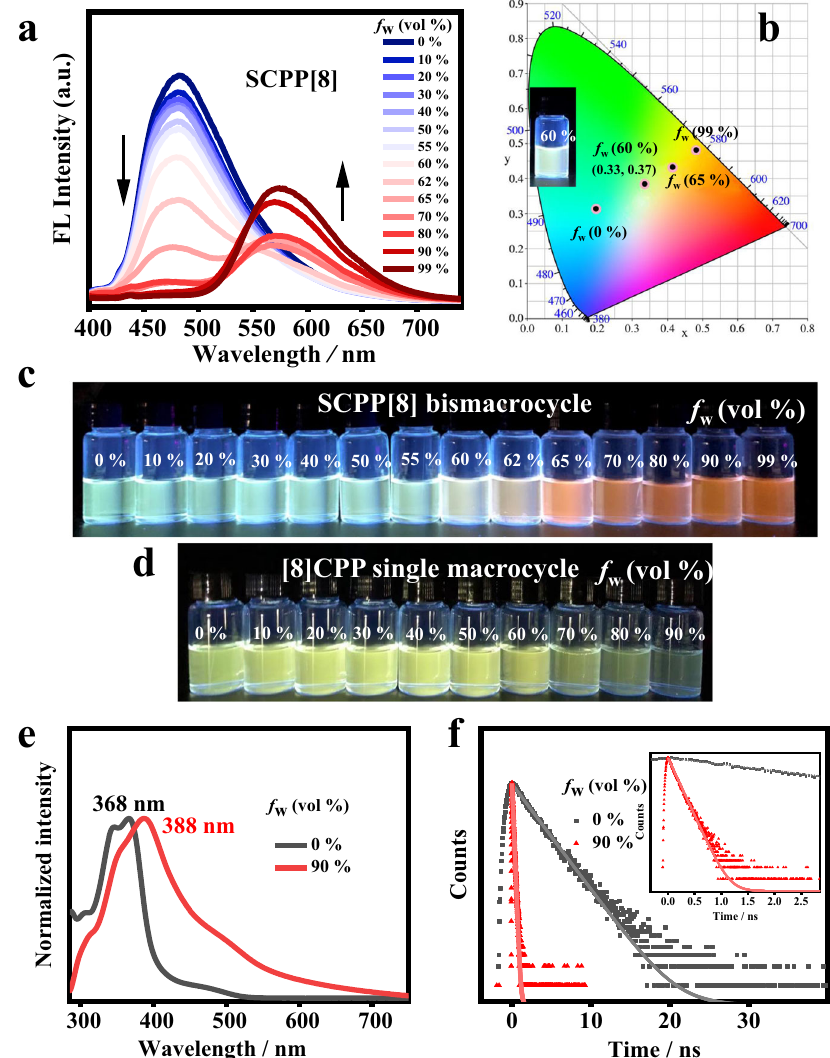
Fig. 5 AIE properties and tunable emission. a Fluorescence spectra of SCPP[8] in THF/H 2 O mixtures with different volume fractions of H 2 O ( f w ). b CIE 1931 chromaticity diagram of SCPP[8] in THF/H 2 O mixtures. Insert: The near white-light of SCPP[8] in aqueous THF with f w = 60 vol% under 365 nm UV light. c Emission color changes of SCPP[8] from cyan to red in aqueous THF with f w = 0-99 vol% under 365 nm UV light. d Emission change of [8]CPP in aqueous THF with f w = 0-90 vol% under 365 nm UV light. e The UV – Vis absorption spectra of SCPP[8] in THF solution and in 90:10 H 2 O/THF ( v / v ) solution. f Emission lifetimes of SCPP[8] in THF solution and in 90:10 H 2 O/THF solution. Insert: Emission lifetime of SCPP[8] in